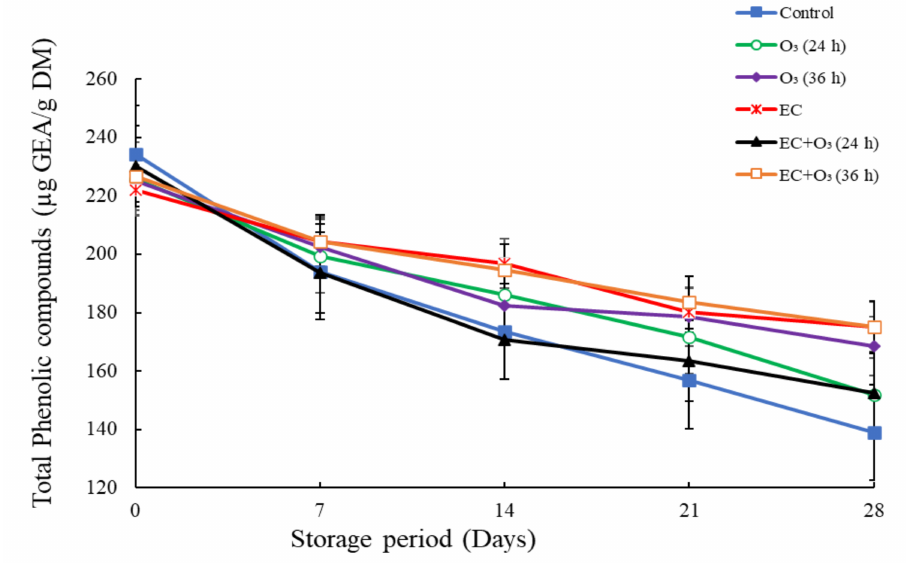
Figure 4. Effect of edible coating (EC) and gaseous ozone (O 3 ) on total phenolics in mango peel during storage at 10 ◦ C for twenty-one days and shelf-life at ambient temperature for seven days ( ± SE, n =